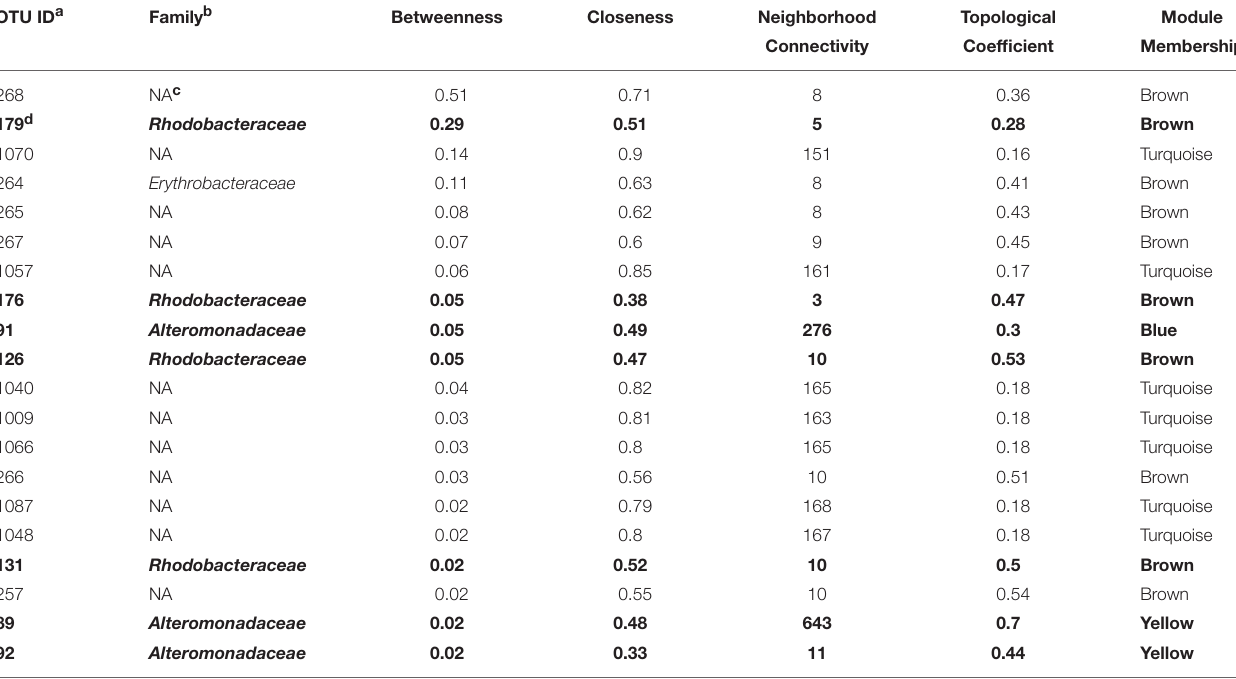
a Assigned OTU identity. b OTU taxonomy at family